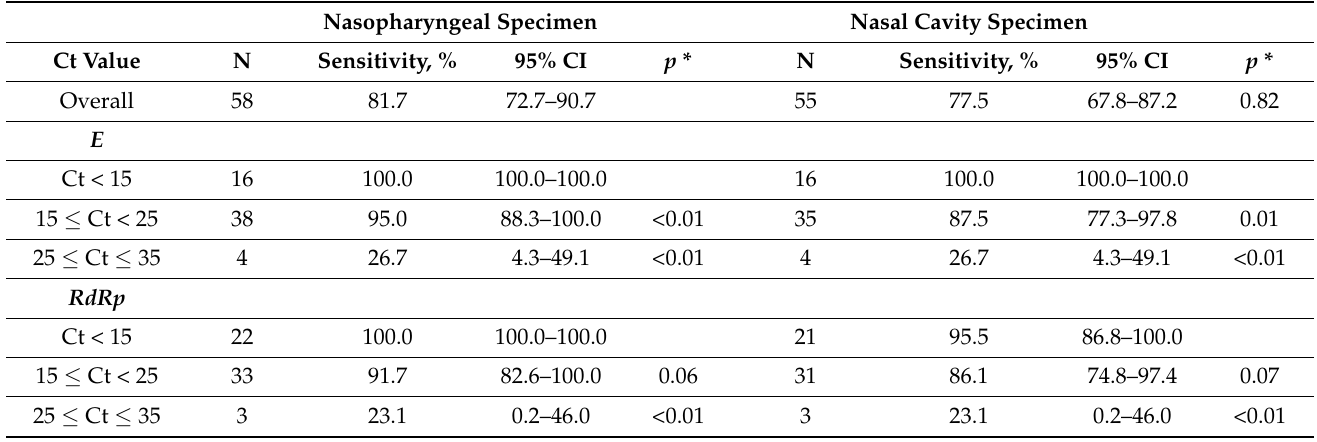
Table 4. Sensitivities of STANDARD Q COVID-19 Ag test according to Ct values for E and RdRp .